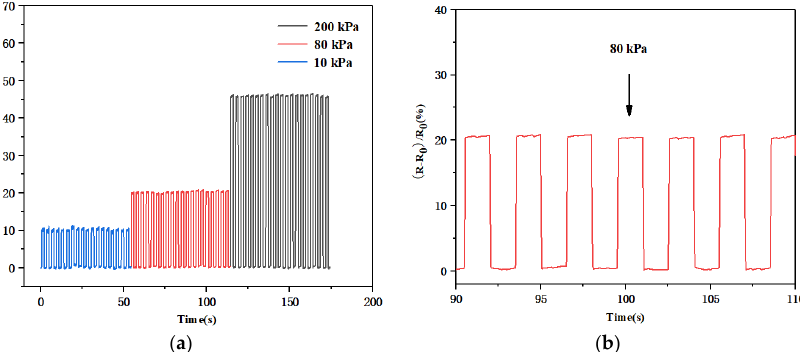
Figure 8. ( a ) Resistive response of the sensor under different periodic pressures (10, 80, and 200 kPa); ( b ) the resistive response of the sensor at 80 kPa.